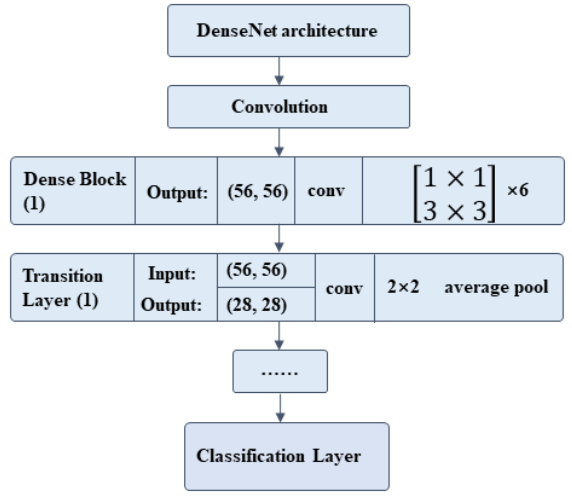
Figure 4. The recognition network architecture for classifying endometrial cell clusters. The size of the